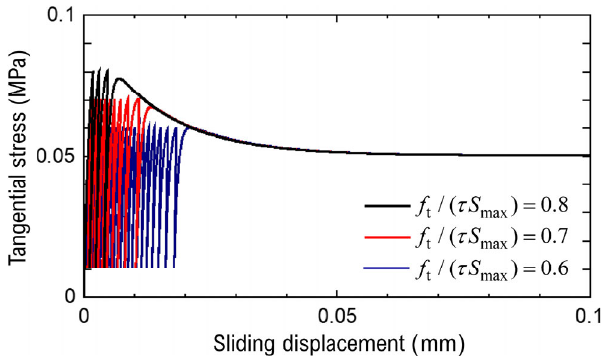
Fig. 5 Typical response for the cyclic frictional behavior under a small amplitude of the tangential stress. Here, the cyclic pulsating tangential stress is applied via sliding velocity control under a constant normal stress f n = 0.3